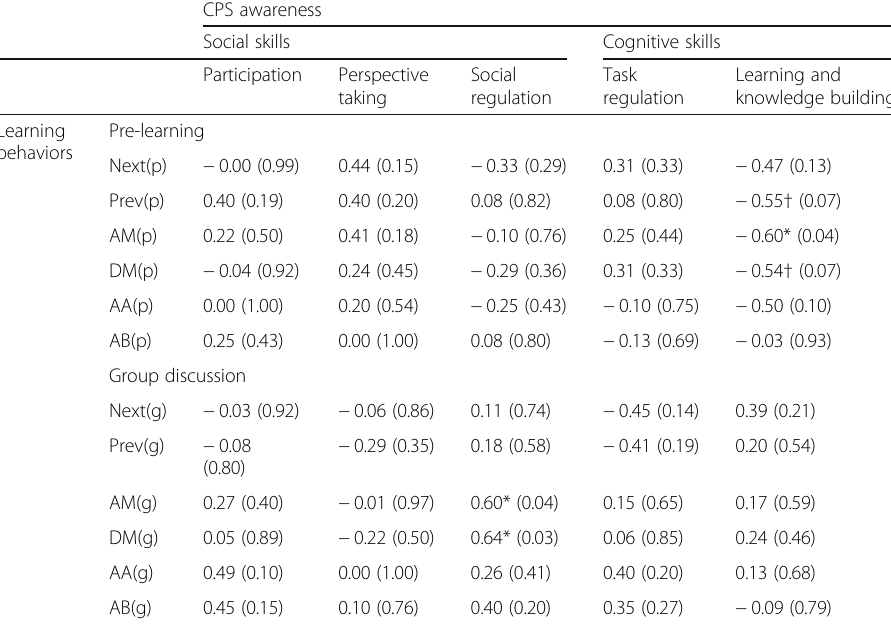
Table 7 Spearman ’ s rank correlation coefficients between CPS awareness and learning behaviors CPS awareness Social skills Cognitive skills Participation Perspective Social taking